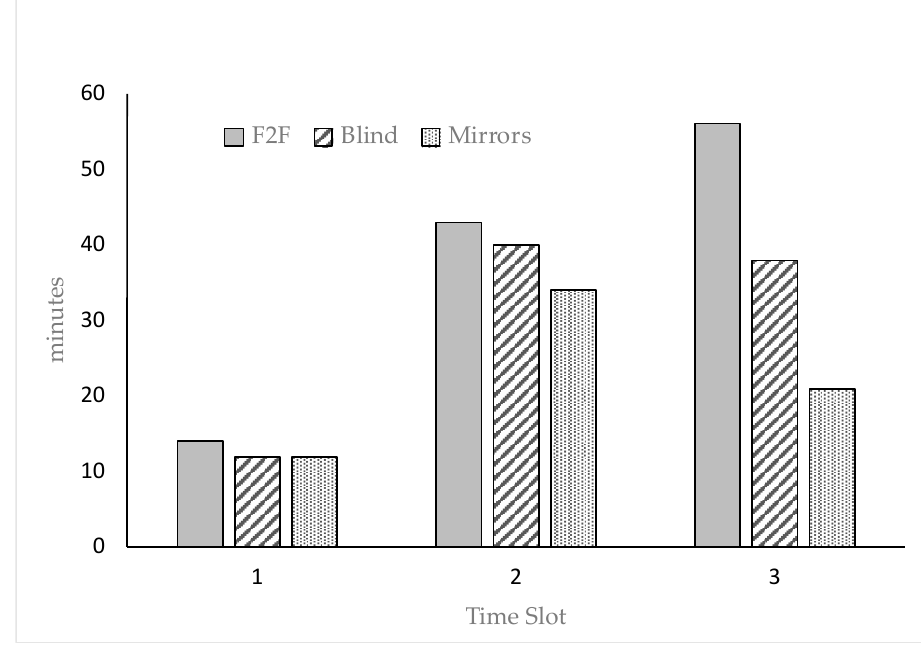
Figure 2. Effect of the interaction group × time of observation (time slot 1 = 8:00 am–4:00 pm; time slot 2 = 4:00 pm–12:00 pm; time slot 3 = 0:00 am–8:00 am) on the locomotory activity of the rabbits.